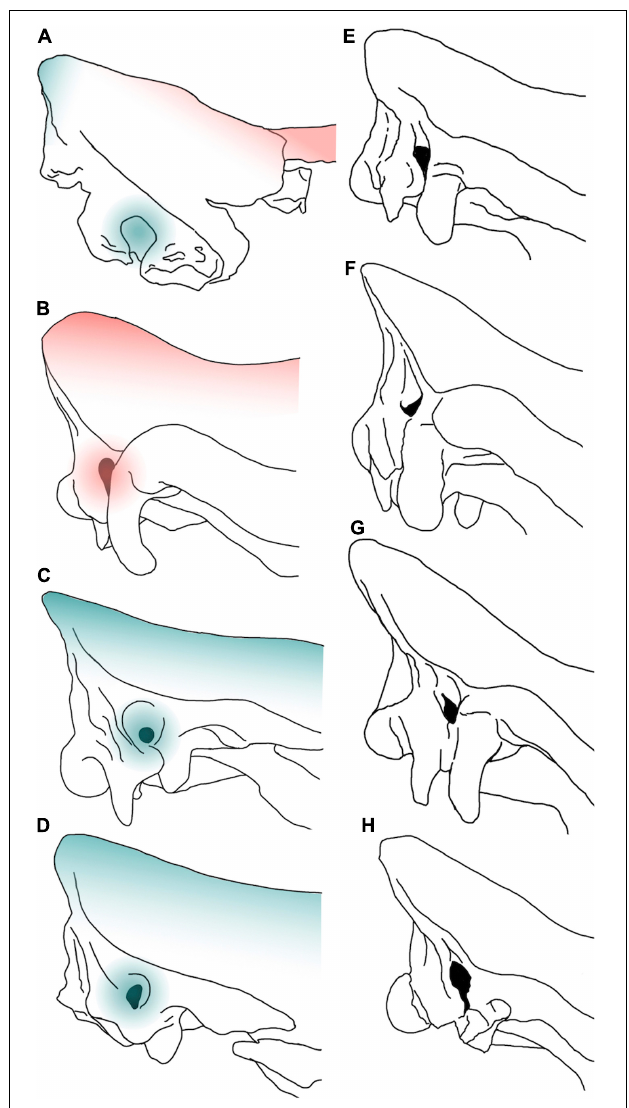
FIGURE 7 | Comparative images in right lateral view of selected braincases of juvenile (A–D) and adult (E–H) Pleistocene Rhinocerotinae from Eurasia. MPND1082 (A) , Stephanorhinus kirchbergensis No. H36 (B) , Coelodonta antiquitatis V 1453 (C) , C. nihowanensis V 17616.1 (D) , S. etruscus Mainz 1958/764 (E) , S. kirchbergensis from Spinadesco (Cremona, norther Italy) (F) , S. hemitoechus RGM 93302 (G) , and C. antiquitatis SfN (H) . The red-colored areas indicate the “ Stephanorhinus ” features, while the blue areas indicate the “ Coelodonta ” features evidenced on the juvenile specimens. The images are not to